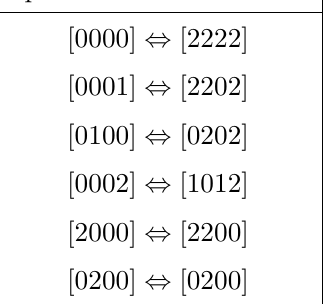
Table 5 . F 4 special nilpotent